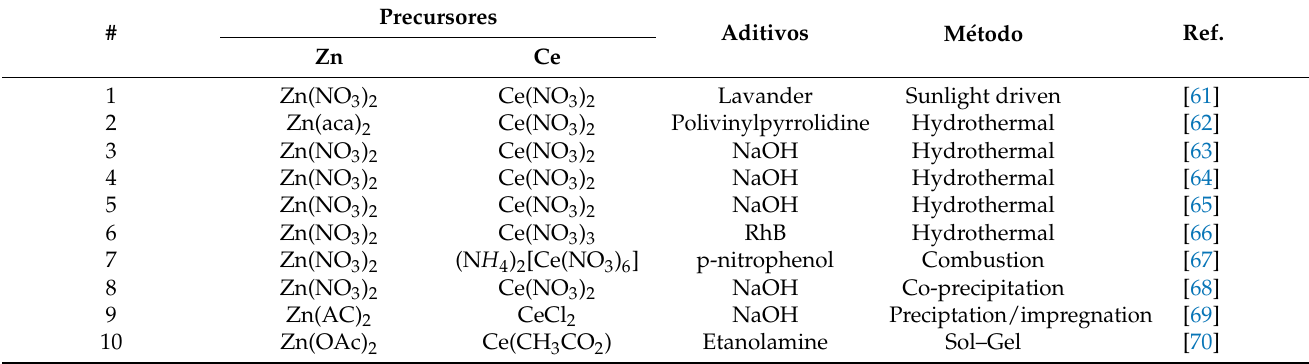
Table 3. Precursors and additives for the synthesis of ZnO-CeO 2 heterojunction.